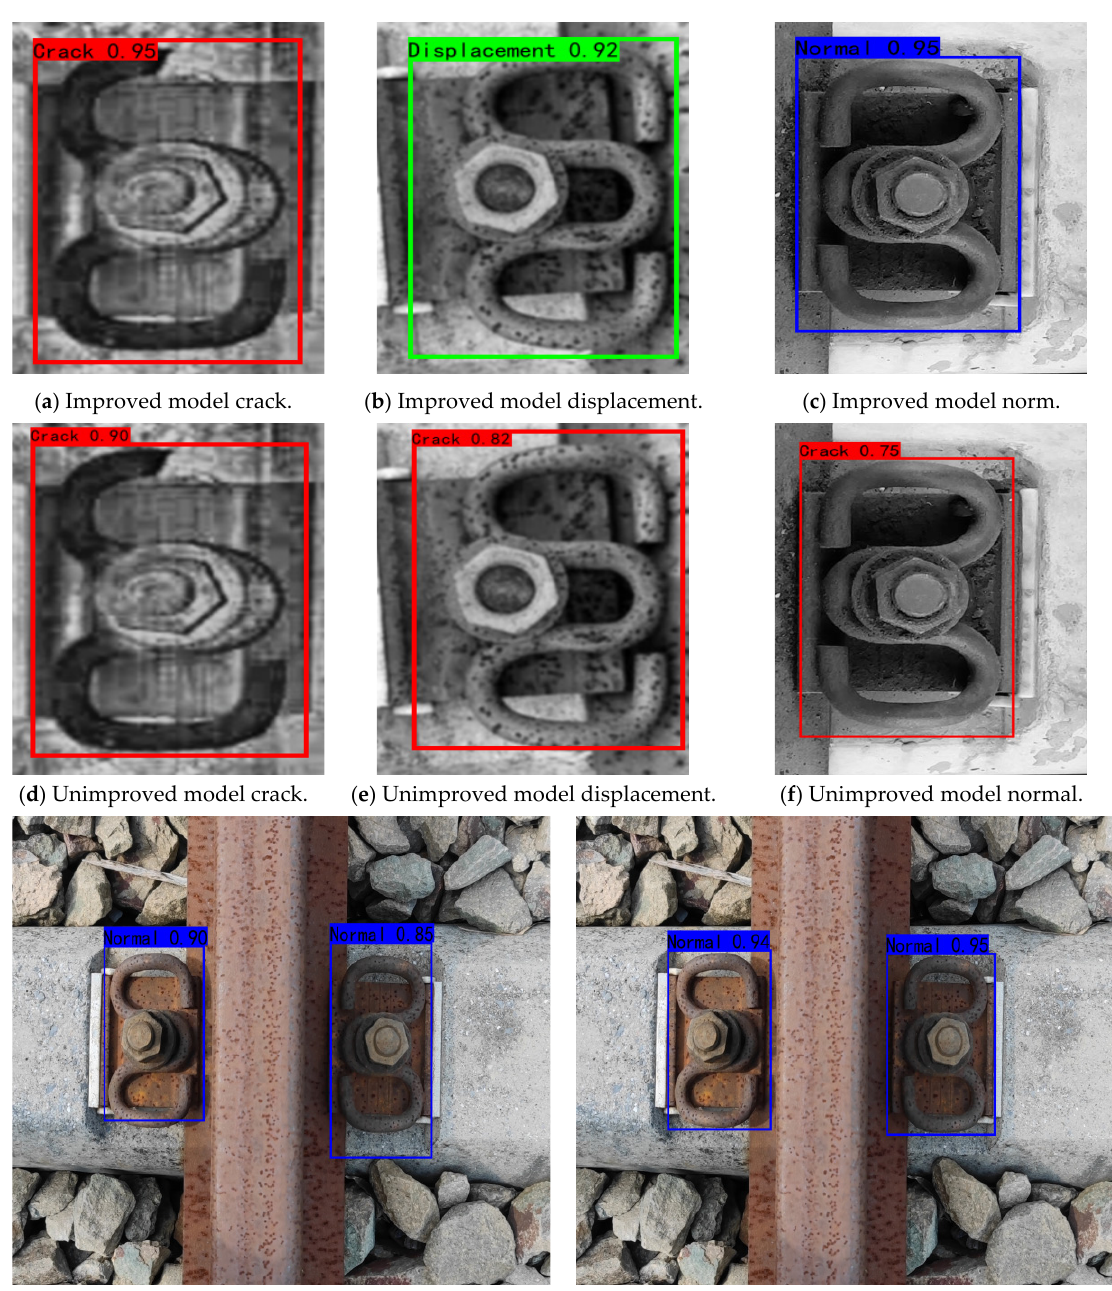
Figure 14. Actual detection images of the unimproved model and improved model.